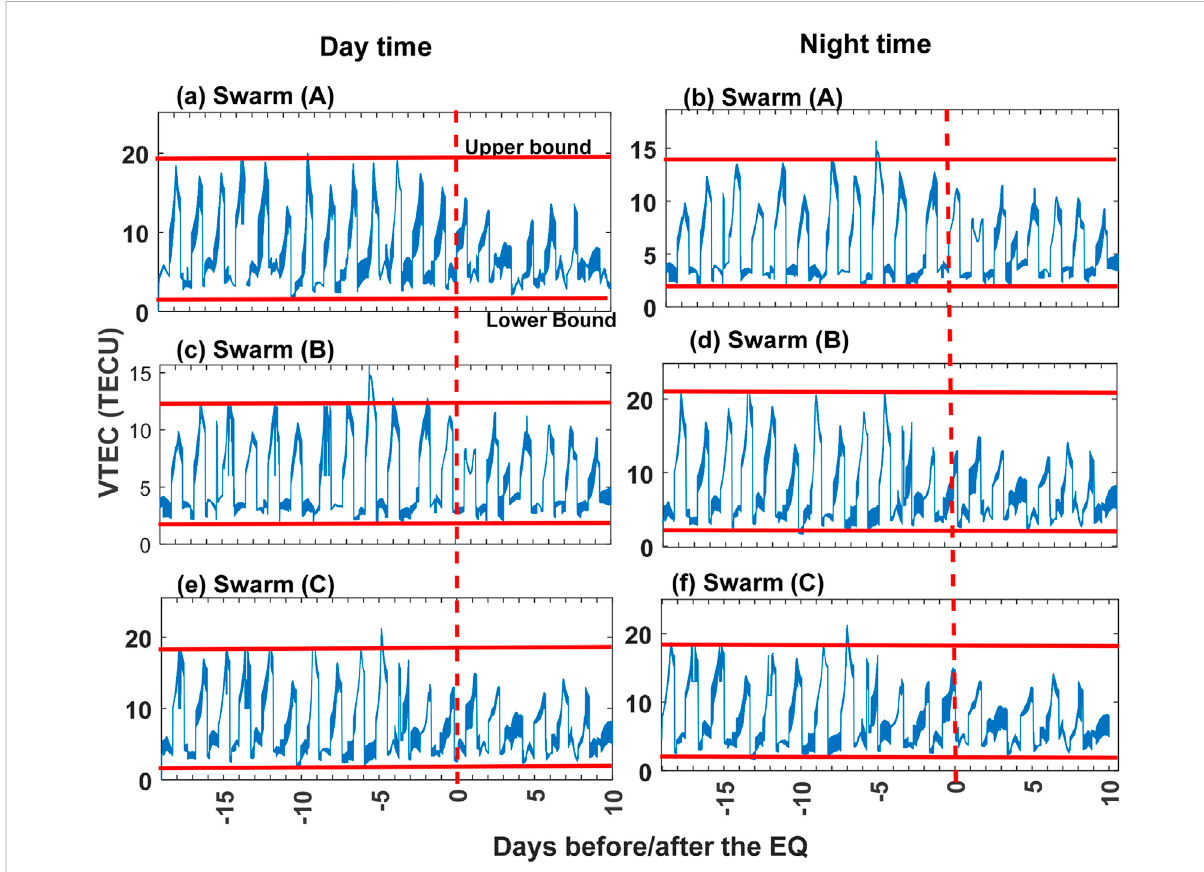
FIGURE 5 TEC from Swarm (A – C) satellites along with the upper and lower con fi dence bounds. The left and right panels are TEC observations during daytime and nighttime periods, respectively. The red dashed line is the representation of EQ